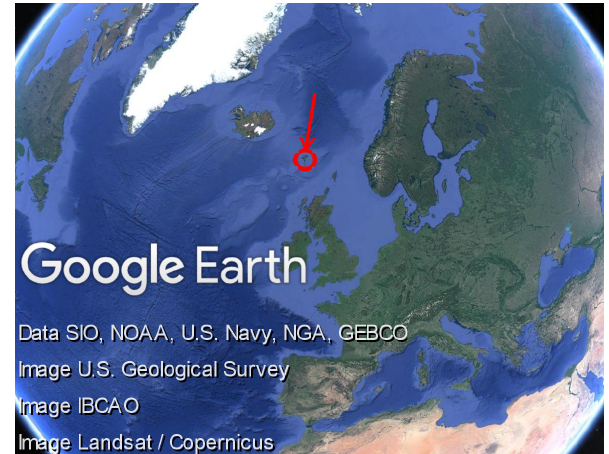
Figure 1. Map generated with the software © Google Earth Pro (see affiliation on the map). The red circle marks the position of the Faroe